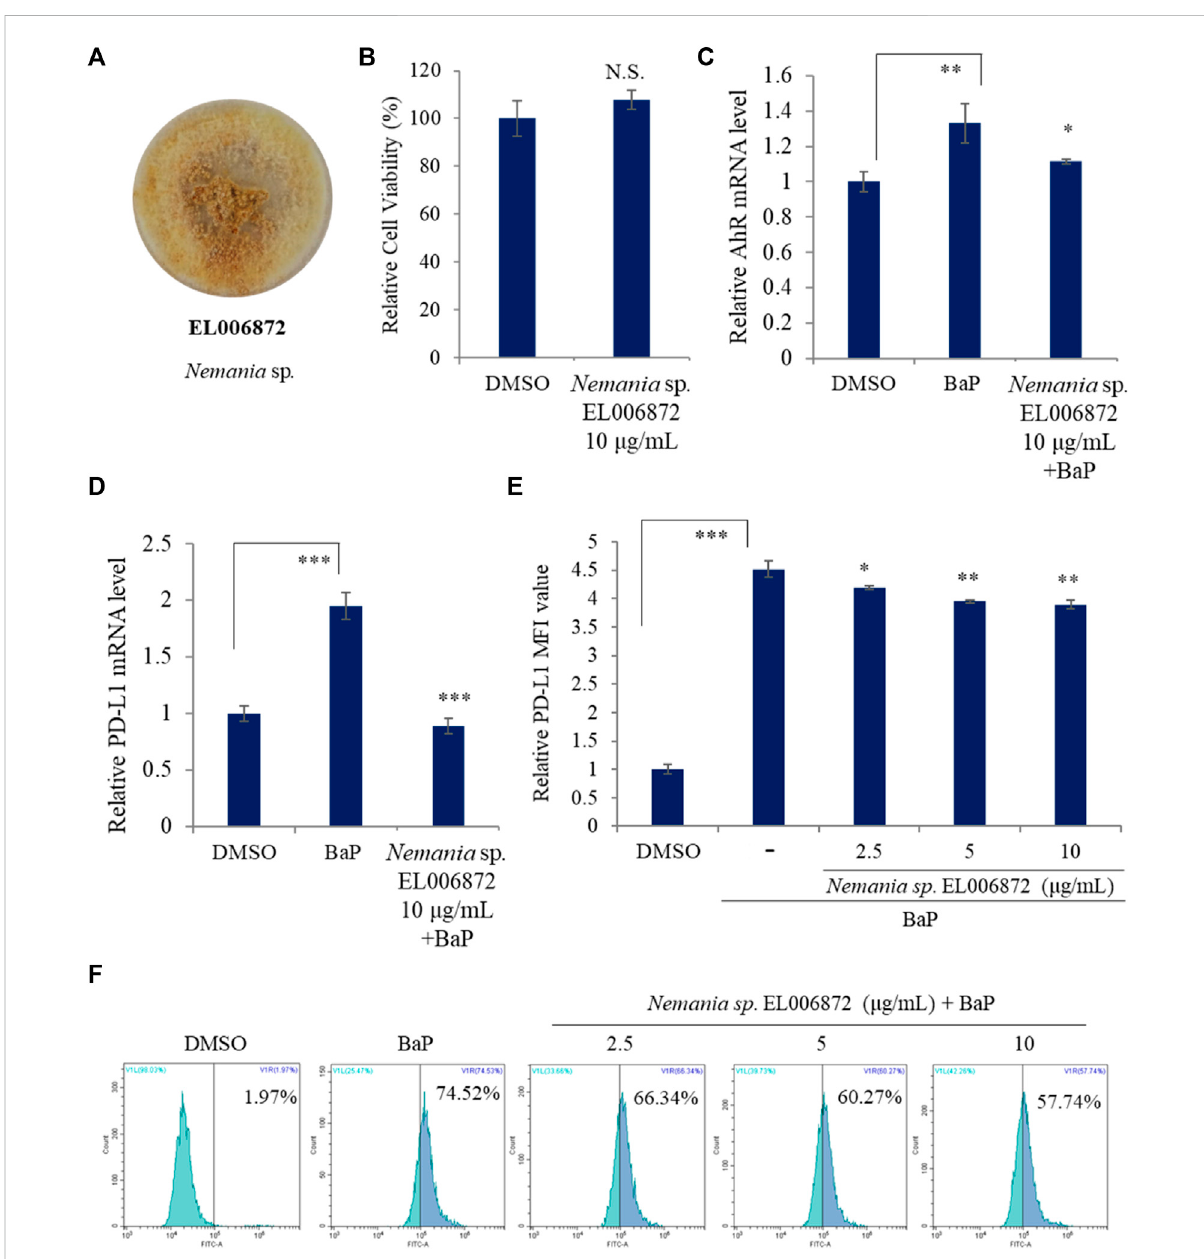
FIGURE 1 Nemania sp. EL006872 inhibits expression of PD-L1 and AhR. (A) Images of the isolated endolichenic fungus EL006872. (B) Effect of Nemania sp. EL006872 crude extract on the viability of H1975 cells. (C,D) Effect of Nemania sp. EL006872 crude extract on PD-L1 and aromatic hydrocarbon receptor (AhR) mRNA in benzo[a]pyrene (BaP) exposed H1975 cells. (E,F) Effects of Nemania sp. EL006872 crude extract on surface protein level of PD-L1 in BaP exposed H1975 cells. MFI: mean fl uorescence intensity. Data are presented as the mean ± S.D. (standard deviation); n = 3. * p < 0.05; ** p < 0.01; *** p < 0.001; NS, no signi fi cant difference compared with the BaP-treated group or between indicated